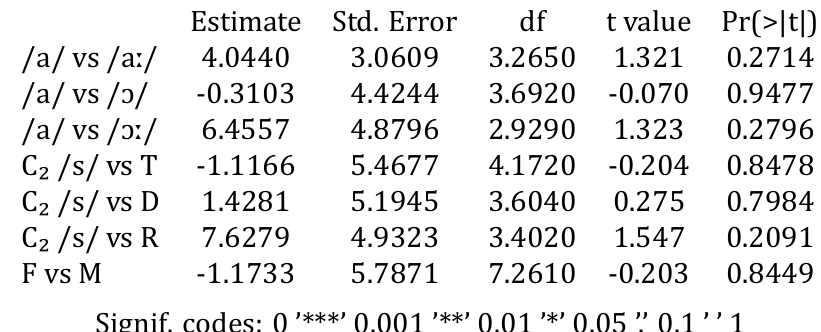
Table A.10: Post-aspiration duration (ms) of C₁ /s/ as a dependent variable